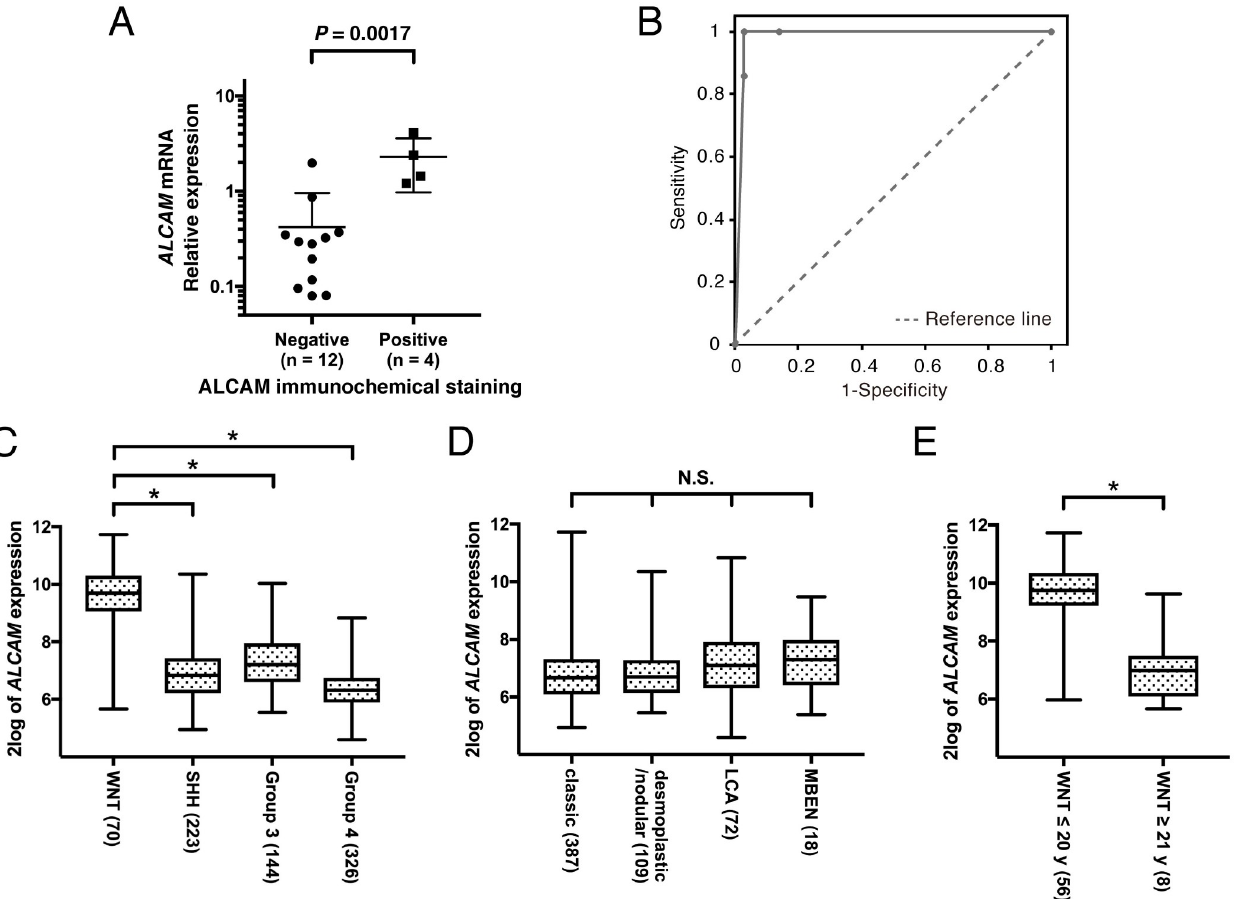
Fig 1. (A) Correlation between ALCAM immunohistochemical staining and ALCAM mRNA expression. ALCAM-positive medulloblastoma (MB) cases showed increased levels of ALCAM compared with the ALCAM-negative cases ( P = 0.0017). The relative expression in human brain (cerebellum) was arbitrarily set at 1.0. (B) Receiver operating characteristic (ROC) curve for positive immunohistochemical expression of ALCAM in WNT subgroup. Area under the curve (AUC), 0.984. (C–E) ALCAM Expression in the Cavalli-763 MB cohort from the R2 Genomics Platform. (C) The WNT subgroup of MB strongly expressed ALCAM as compared with the other subgroups. (D) There was no clear correlation between ALCAM expression levels and histologic MB subtypes. (E) In the WNT subgroup of MB cases, ALCAM expression differed between the ages � 20 y and � 21 y. The box-and-whisker plots show the medians (thick horizontal lines) and interquartile ranges (IQRs; boundaries of the box) and ranges. � : P < 0.0001; N.S.: not significant.